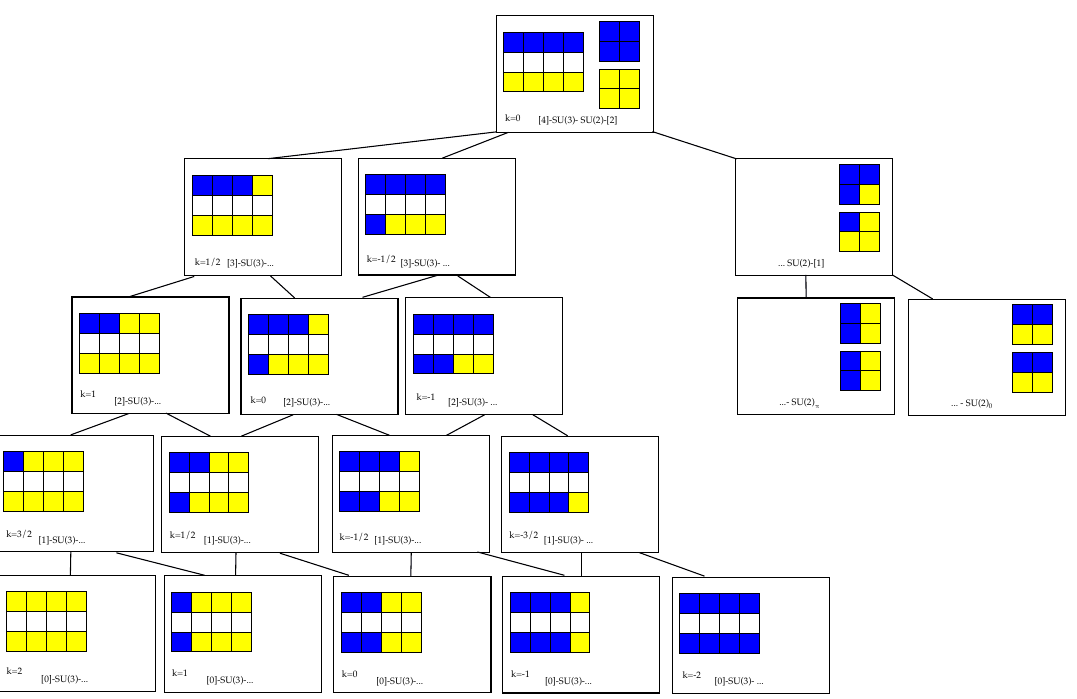
Figure 20 . Box graphs for T 4 in the weakly coupled description as a quiver [4] (cid:0) SU(3) (cid:0) SU(2) (cid:0) [2]. Each extended Coulomb branch phase is characterized by a pair of box graphs for SU(3) (left hand branch) and for SU(2) (right hand branch). The CS-level of the SU(3) is denoted by k